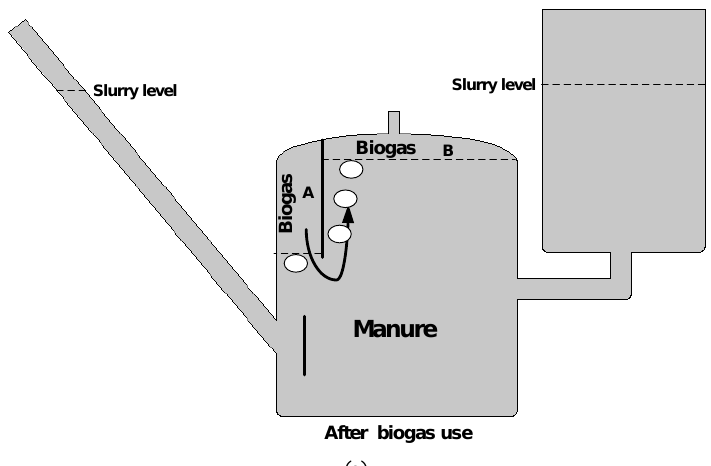
Figure 2. Scheme of the biogas production in the optimised digester ( a ) before biogas production. ( b )